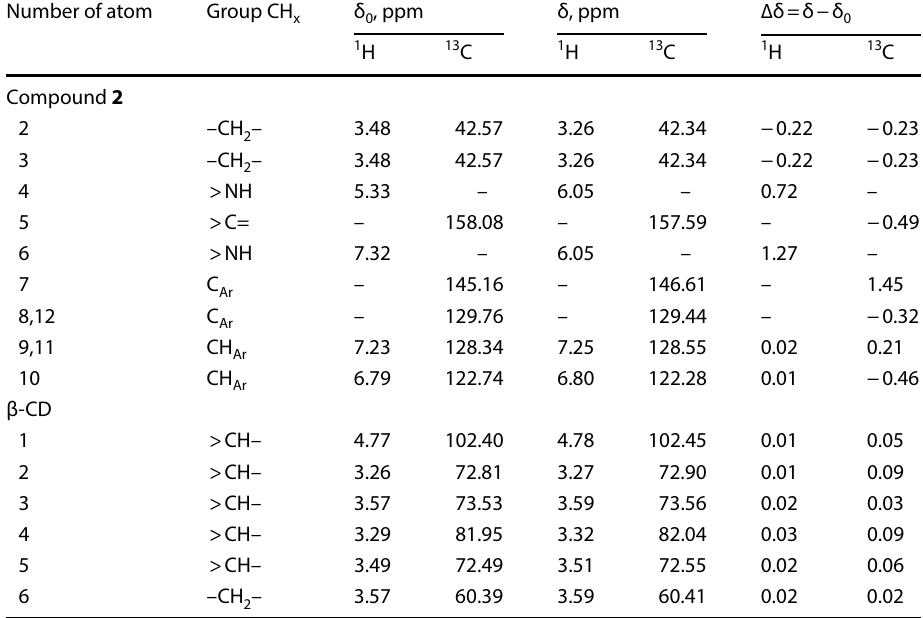
Table 2 1 H и 13 C NMR chemical shift changes (ppm) for 2 and β-CD before (δ ) and after the 0 formation of complex 5